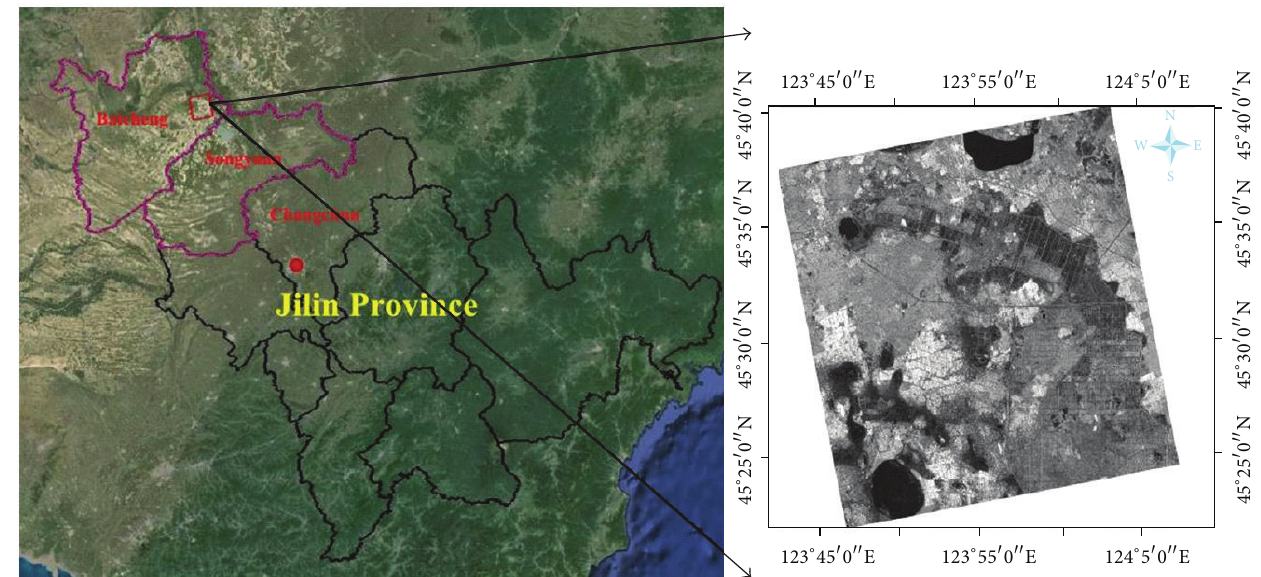
Figure 1: Location of the study area (the image on the right is the HH polarization of RADARSAT-2).